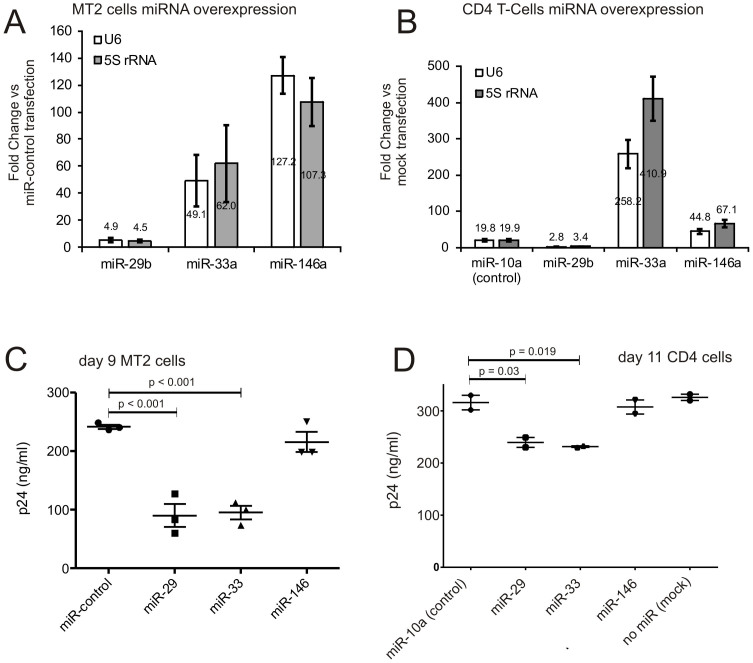
miRNAs interfere with HIV replication.(A) Real-time qPCR analysis of hsa-miR-29b-3p, hsa-miR-33a-5p and hsa-miR-146a was performed 48 hours post transfection in MT2 cells. Two independent reference genes (U6 and 5S rRNA) were used for normalization and fold changes in miRNA levels relative to a scrambled negative control miRNA (fold-change = 1, not shown) were calculated as average from 3 independent transfections (+/−SD). (B) Analogous qPCR data for CD4 cells. hsa-miR-10a was included in this experiment as non-functional negative control, since it was not differentially present in plasma samples of CH, EC and HD. (C) Forty eight hours after transfection MT2 cells were infected with HIV-NL4.3. p24 antigen titers are given in ng/ml at day 9 post infection of MT2 cells. (D) p24 antigen titers from supernatant of primary CD4-positive T cells at day 11 after infection with HIV. As shown, the overexpression of hsa-miR-29b-3p and hsa-miR-33a-5p reduce significantly the production of p24 antigen (MT2 cells: hsa-miR-29b-3p p < 0.001 and hsa-miR-33a-5p p < 0.001; primary CD4-positive cells: hsa-miR-29b-3p p = 0.03 and hsa-miR-33a-5p p = 0.019). Three independent infections after miRNA or scrambled-control transfections were performed and the respective p24 titers are shown for each infection as average of two technical replicates.